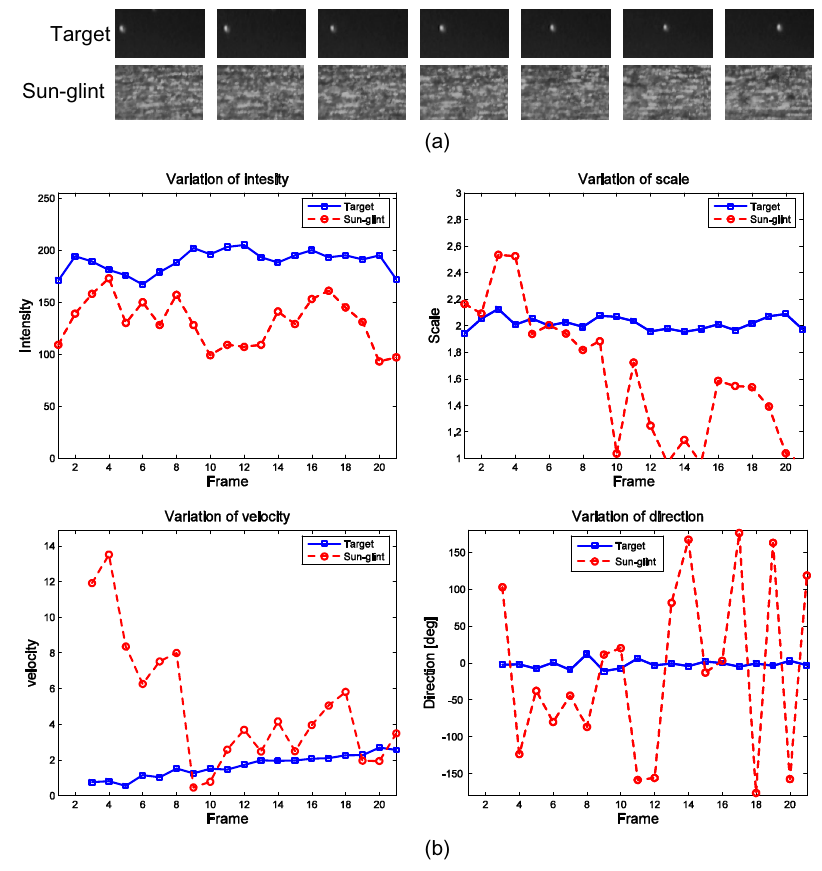
Figure 16. Observation of a target and sun-glint: ( a ) sequence of a target and sun-glint; ( b ) observation results in terms of the intensity, scale, velocity and moving